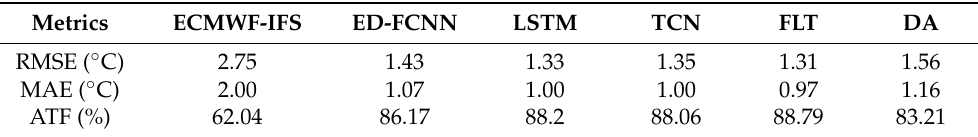
Table 3. Mean verification metrics of each neural network model for daily maximum temperature on the test set.